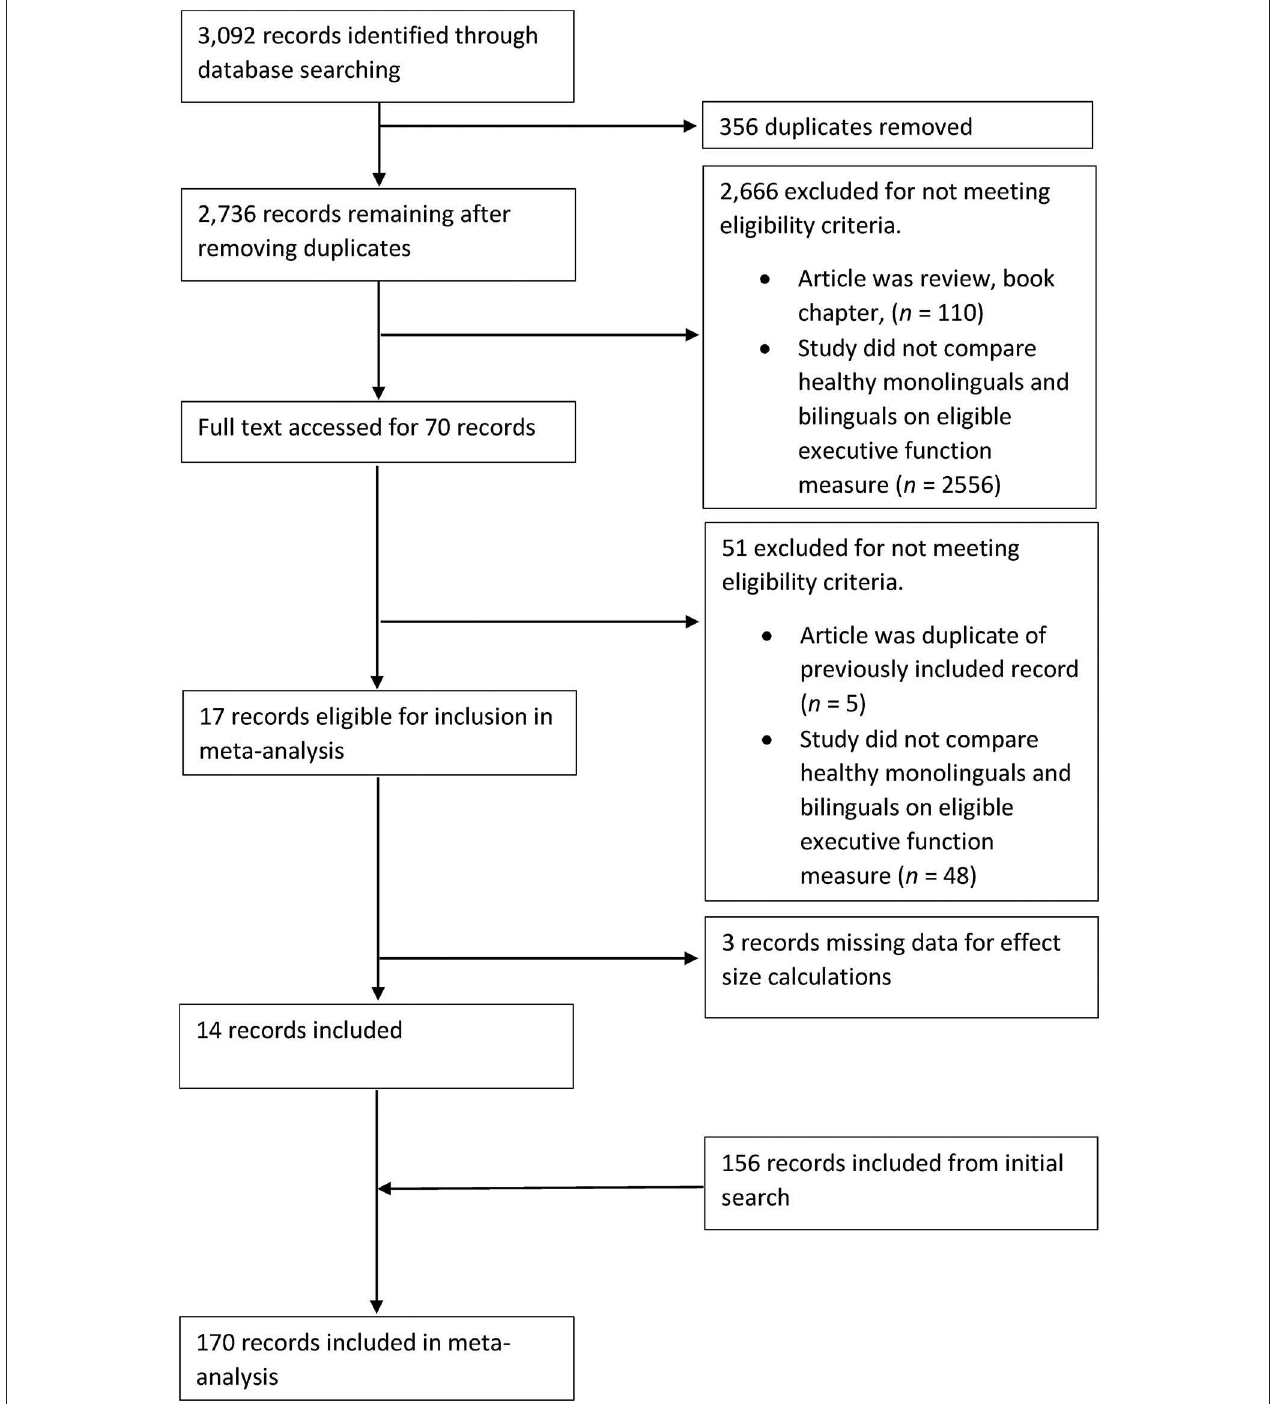
FIGURE 3 | PRISMA flowchart detailing the third search of the literature undertaken in December,